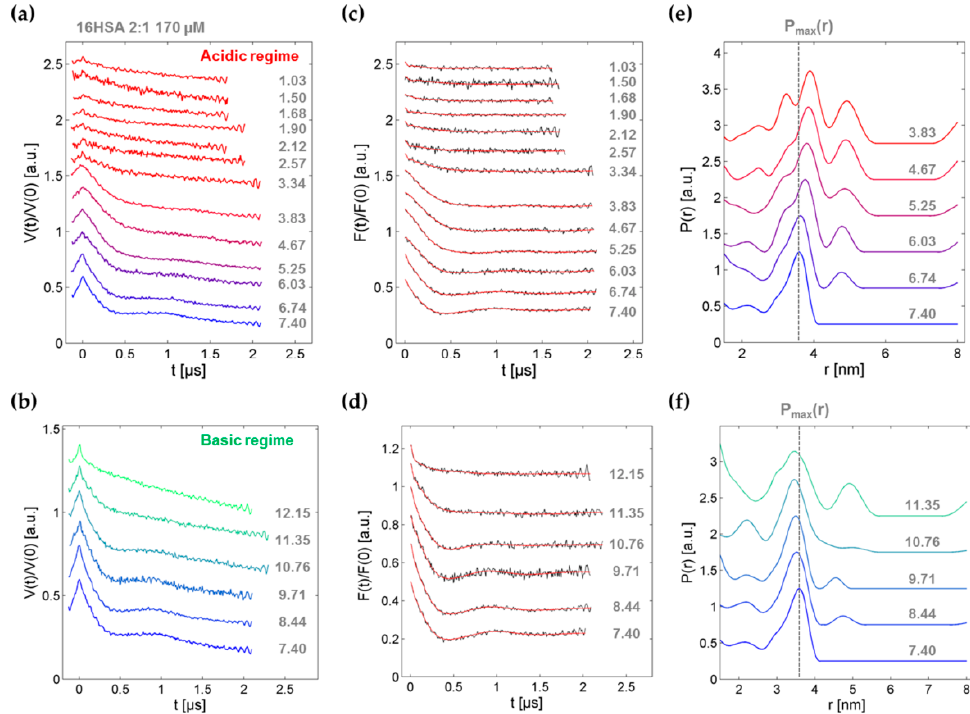
Figure 8. DEER experiments on 16 ‐ DSA ‐ probed HSA at various pH values. All DEER data were recorded from 16 ‐ DSA ‐ probed HSA solutions in the range from pH 1.03–12.15 and are subdivided in acidic (pH ≤ 7.4) and basic (pH ≥ 7.4) experimental data. The FA loading ratio was set to 16HSA 2:1 at 170 μ M equivalents. Raw DEER time traces V ( t )/ V (0) are shown in ( a ) the pH range from 1.03–7.40 and ( b ) pH 7.40–12.15. Dipolar evolution functions F ( t )/ F (0) (black) with regularized fits (red) are shown in the range ( c ) from pH 1.03–7.40 and ( d ) pH 7.40–12.15. Distance distributions P ( r ) from data shown in ( c , d ) are shown in ( e ) from pH 3.83–7.40 and ( f ) pH 7.40–11.35. The gray dotted lines in ( e , f ) are an aid to the eye for indicating relative changes compared to P max ( r ) at physiological conditions ( r = 3.58 nm, pH